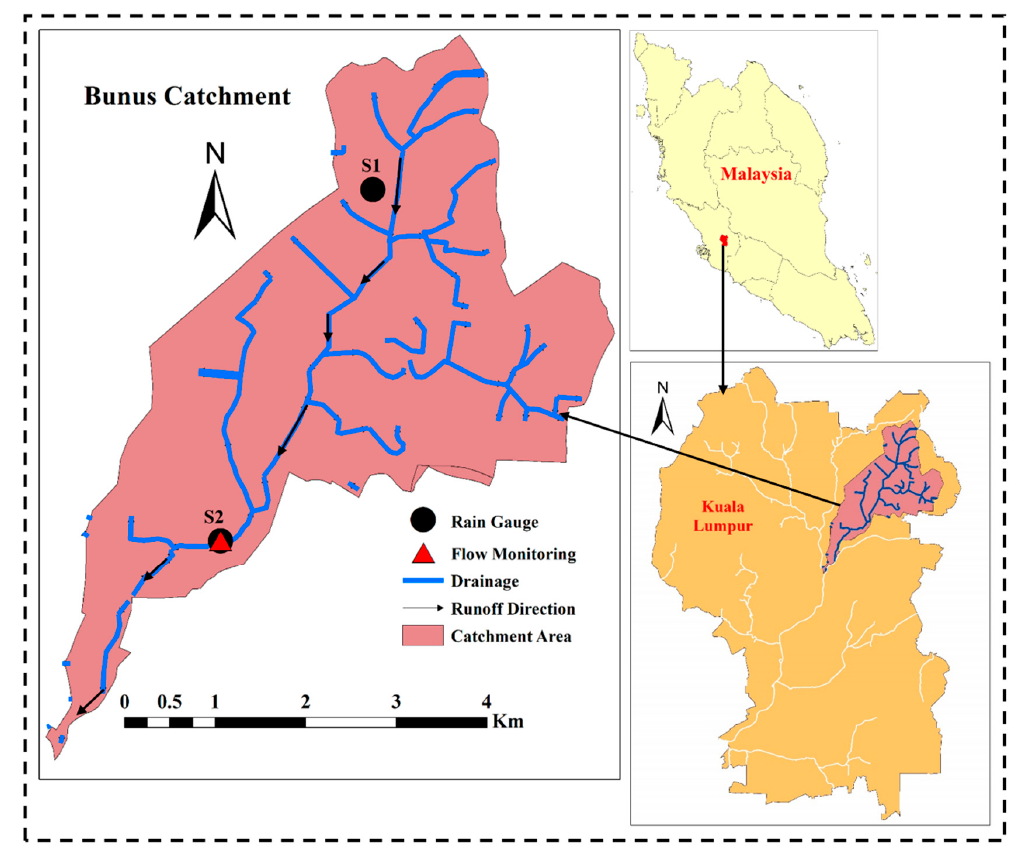
Figure 1. Study area location within Kuala Lumpur, Malaysia.